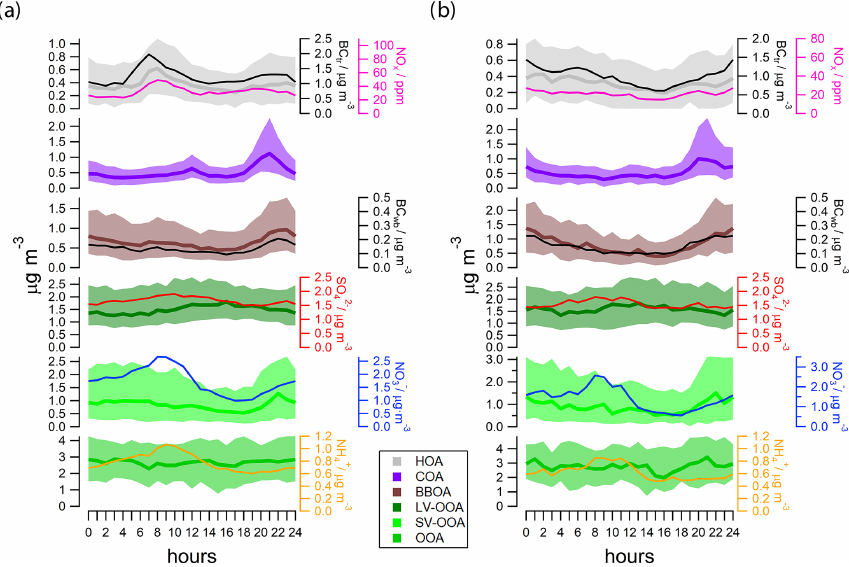
Figure 4. The weekday (a) and weekend (b) diurnal cycles for the entire period (February 2011–February 2012). The thick lines represent the medians and the shaded areas span the interquartile ranges. Typical external tracers are also shown for comparison, i.e., eBC tr and NO x for HOA, eBC wb for BBOA, SO 2 − for LV-OOA, NO − for SV-OOA and NH + for OOA. 4 3 4 Table 3. Correlation coefficients ( R 2 ) with a significance level of p ≤ 0 . 01 between the factor contribution and expected tracers over Pearson the year and the meteorological seasons as defined above. The first value describes the correlation for the rolling result, whereas the value in brackets is for the seasonal PMF result (no rolling). Factor Year